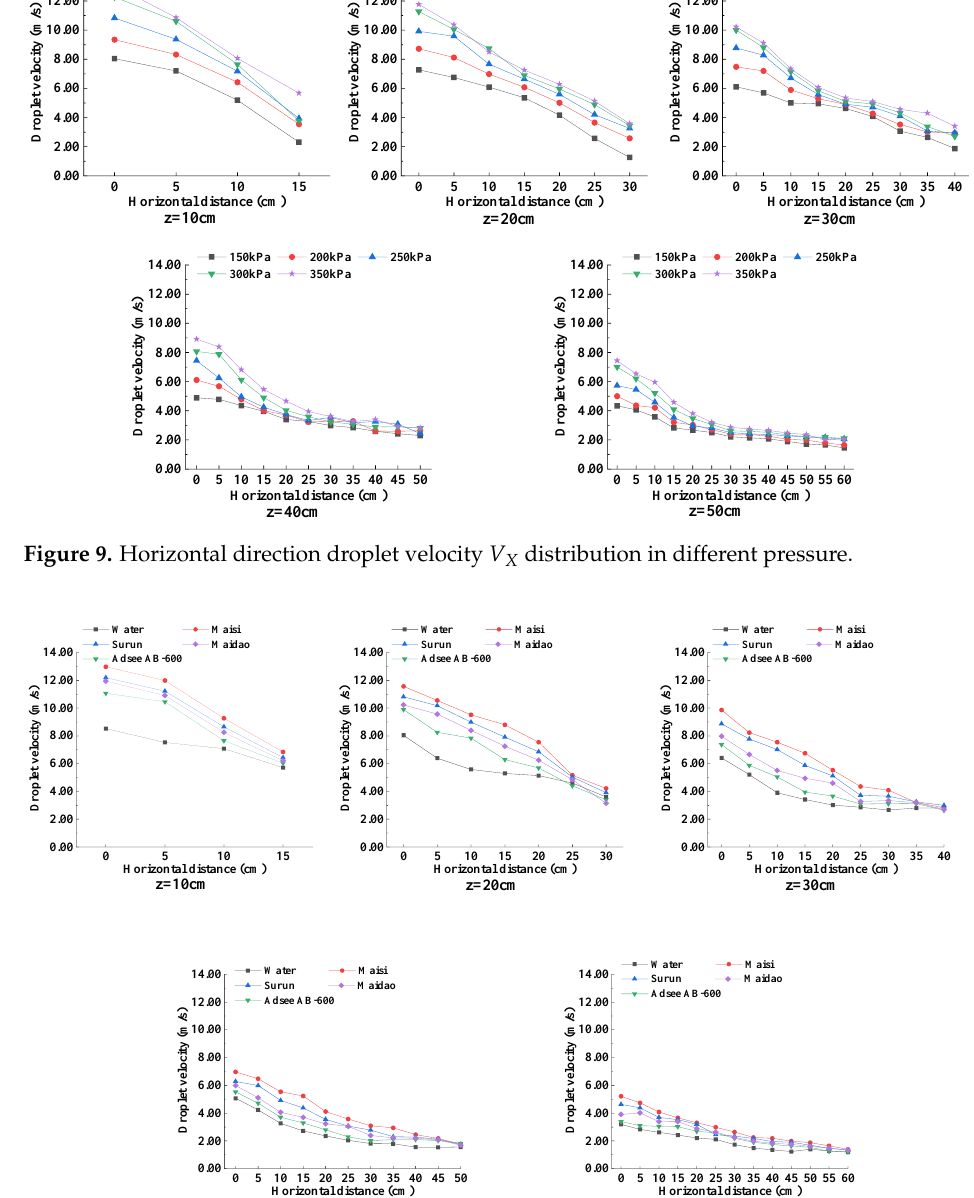
influence of air power. Near the edge, the number of droplets is rare, and the conditions for reducing velocity change are few.